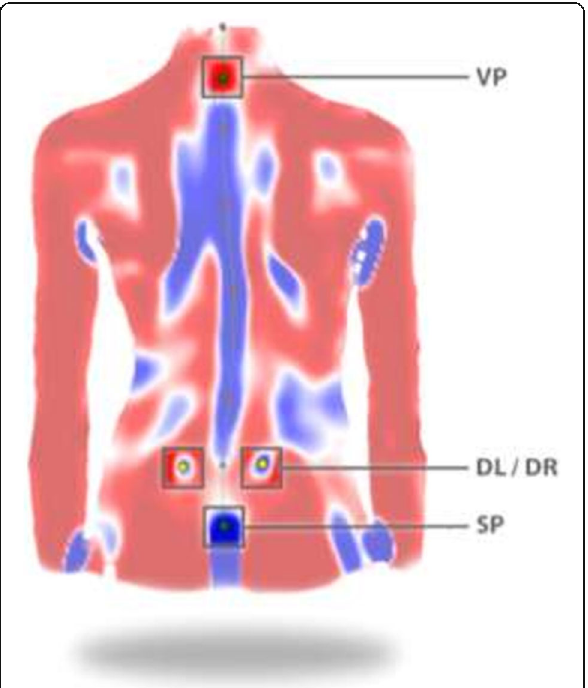
Fig. 3 The anatomical landmarks (vertebra prominence, left dimple, right dimple, and sacrum point) which were detected automatically by the Formetric